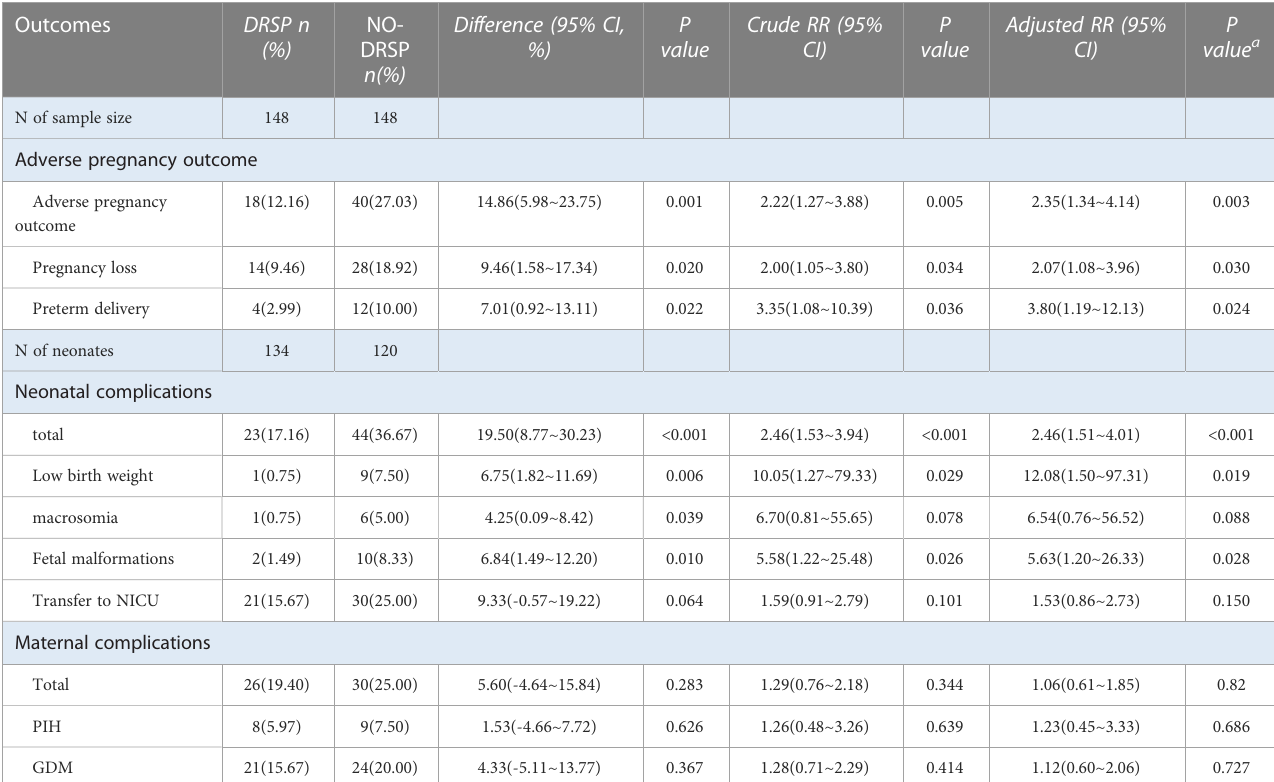
TABLE 2 Comparison of pregnancy outcomes between two groups. （ VS. DRSP ）